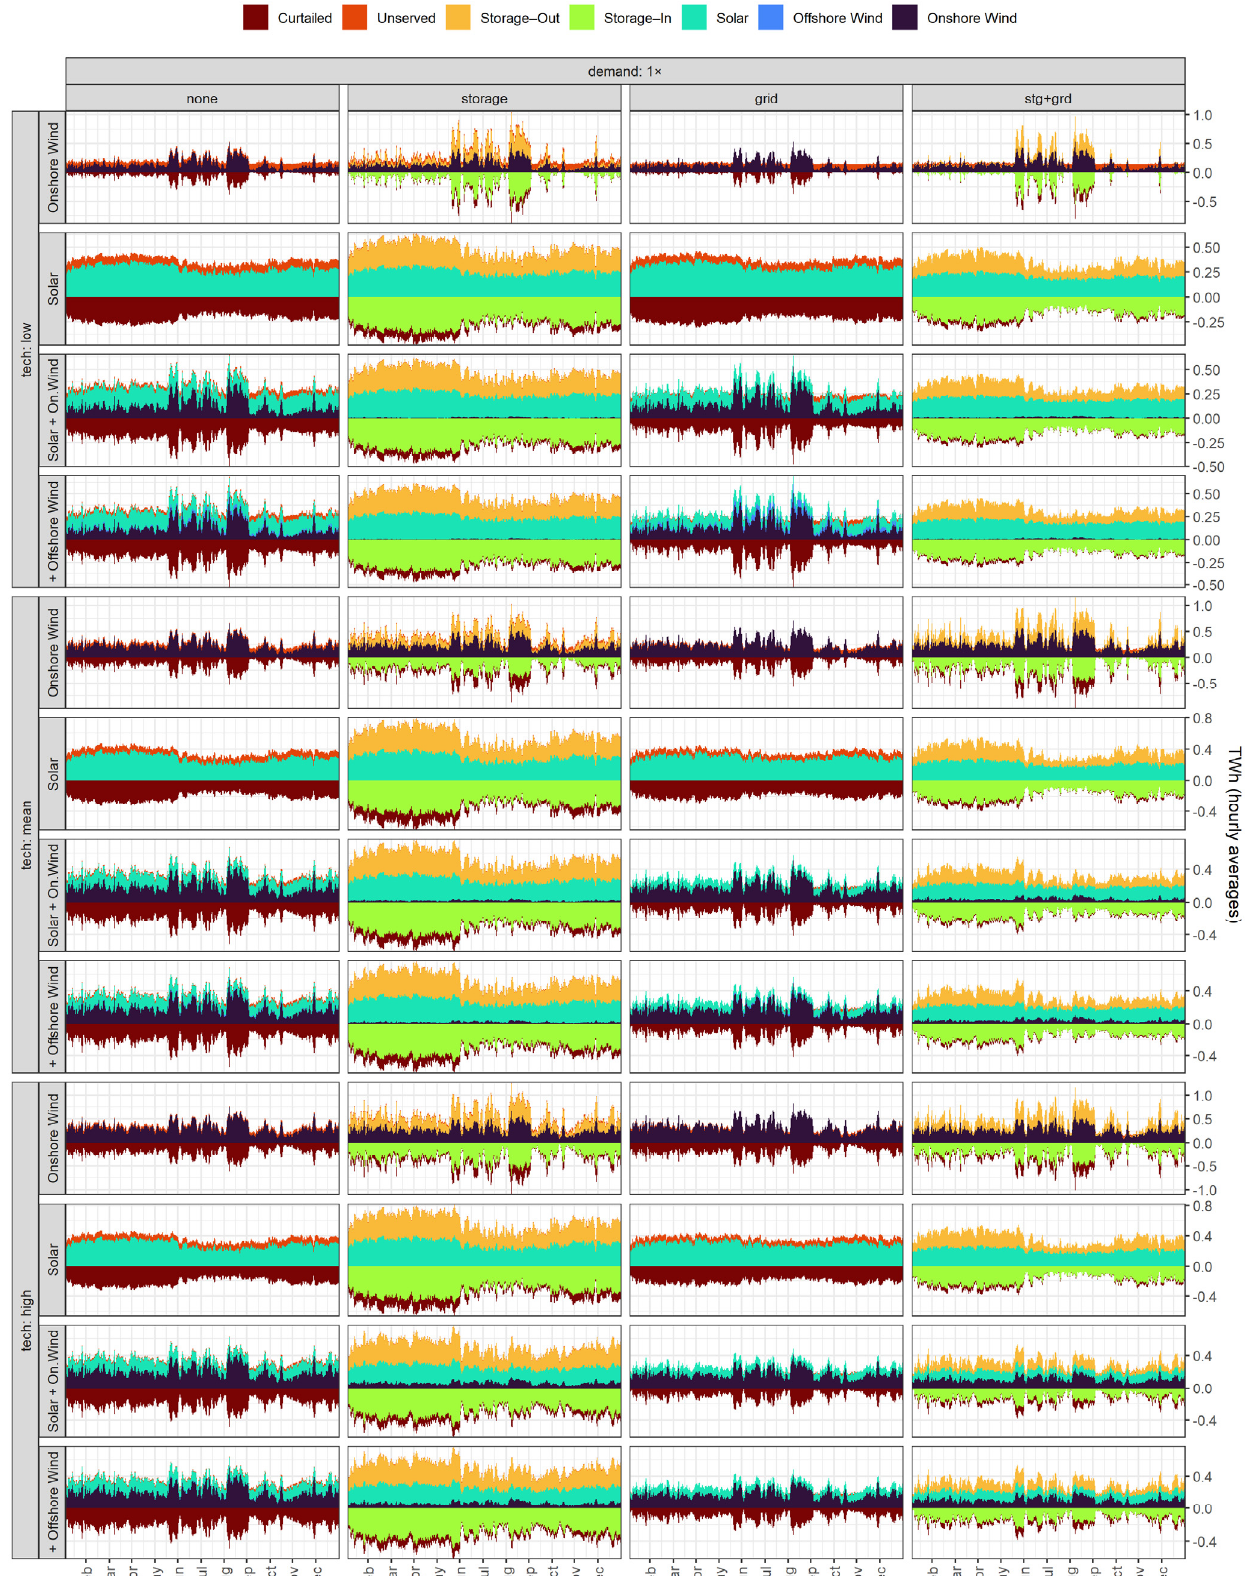
Figure A20. Annual operation profile by scenario (1 × group), national aggregation, 2020 weather year.